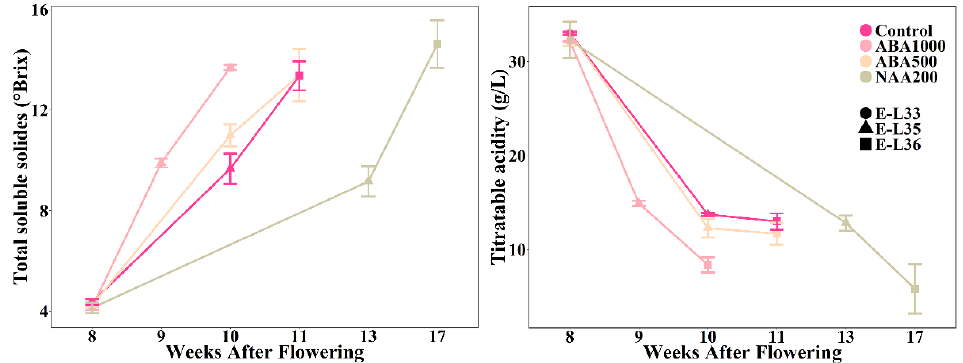
Figure 1. Changes of total soluble solids and titratable acidity in the control, ABA1000-treated, ABA500-treated and NAA200-treated grape berries.